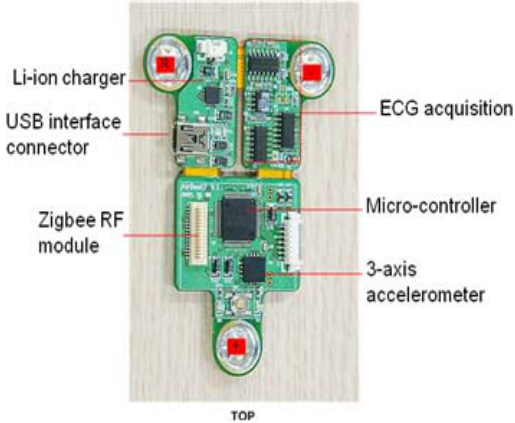
Figure 2. Patch-type sensor board with 3-axis accelerometer and ECG